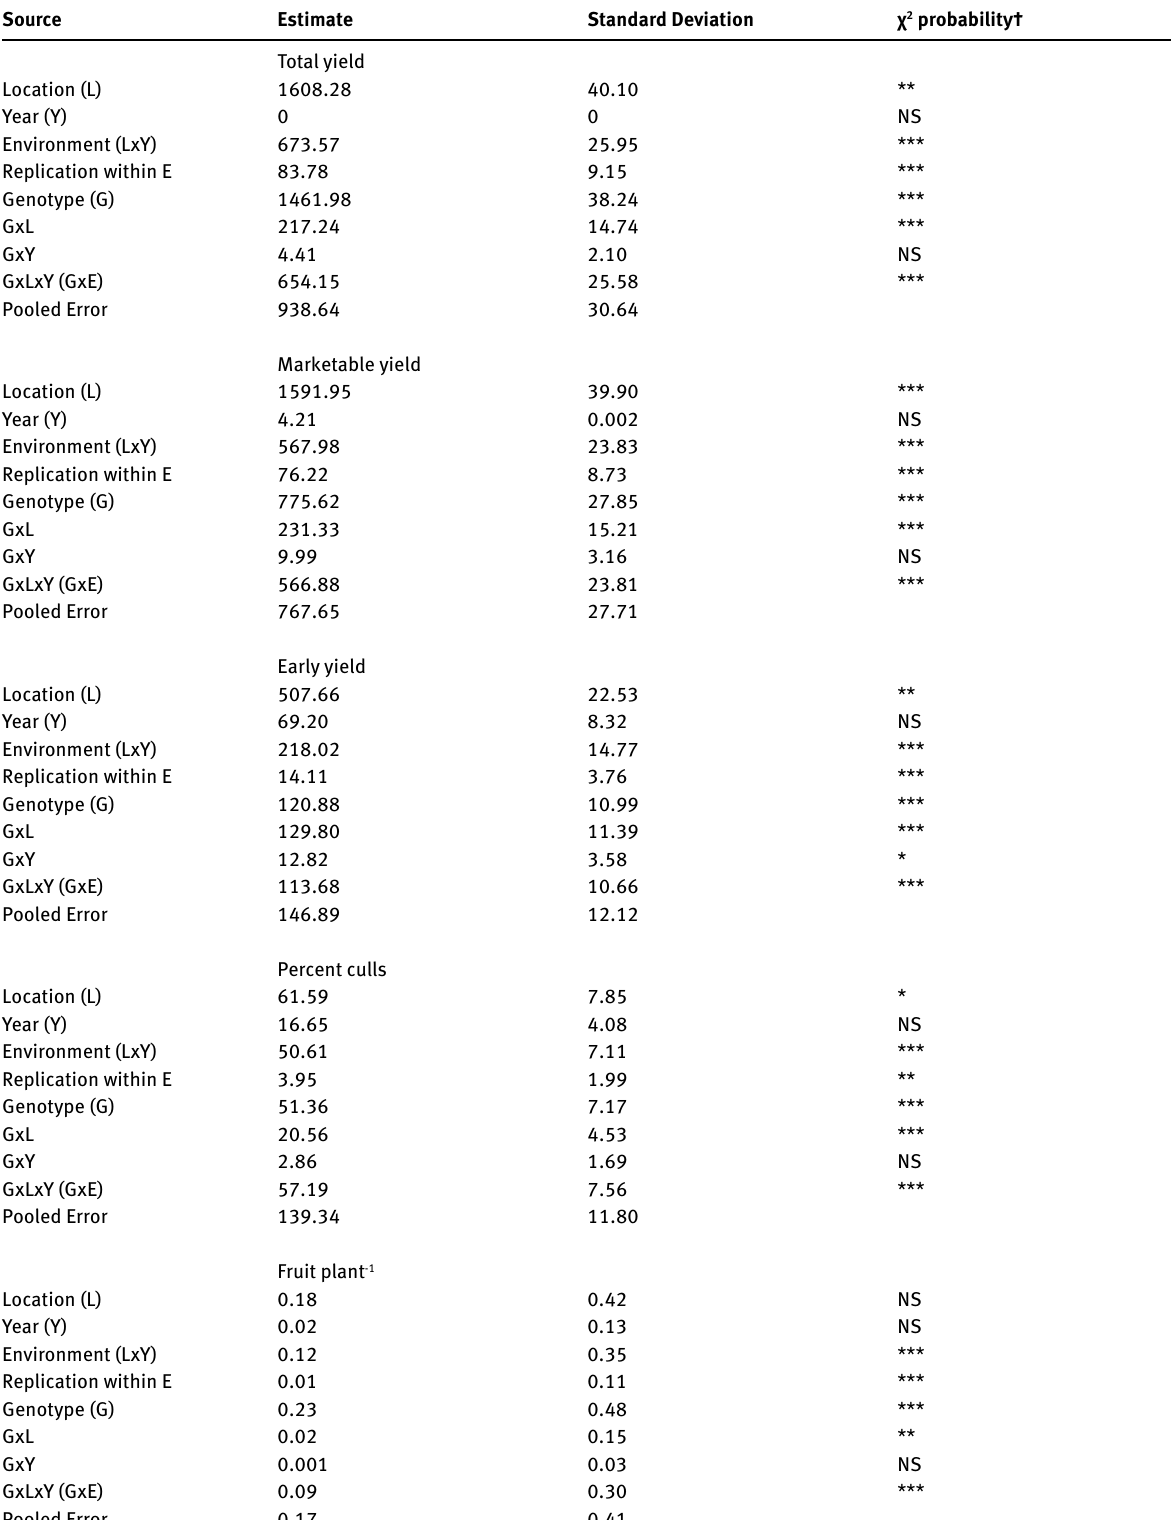
Table 2: Variance analysis of total, marketable and early yield (1000 ha -1 ), percent culls and fruit per plant of 22 cucumber genotypes tested in 3 years and 24